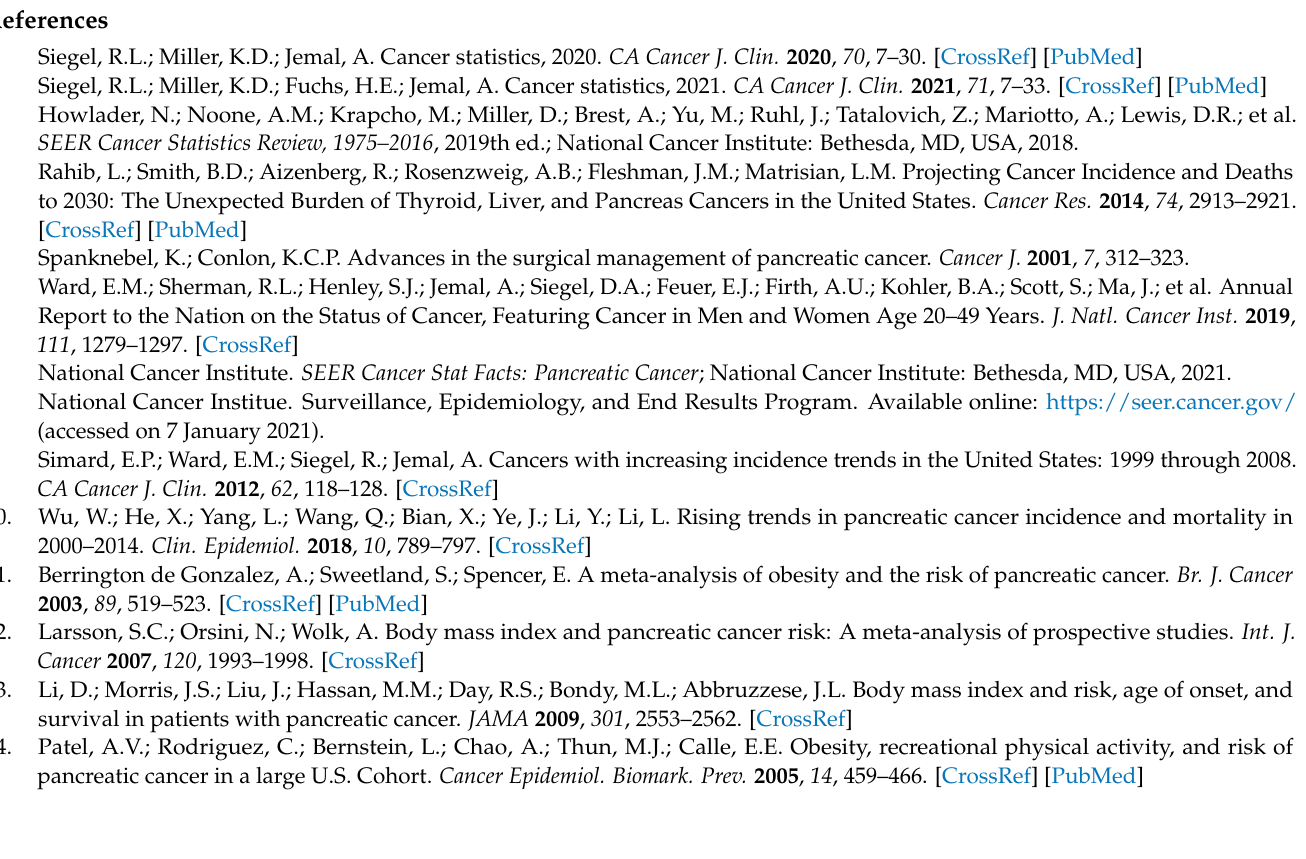
Figure A1. Untreated Patients with EOPC.